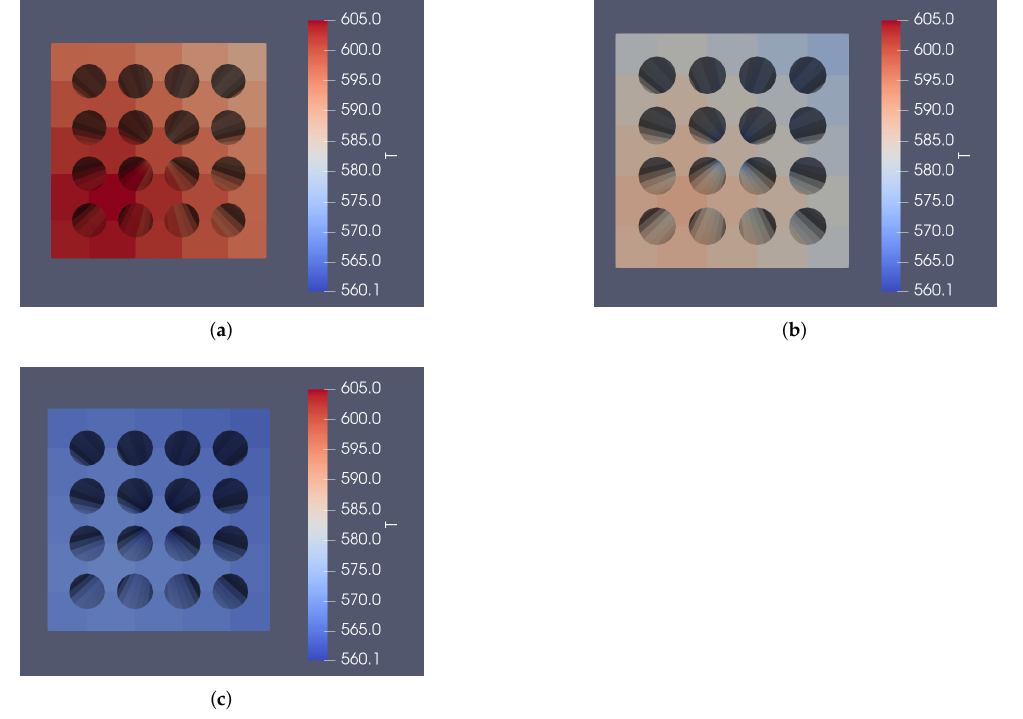
Figure 16. Temperature profile at assembly cross-sections for a non-uniform lateral power profile.